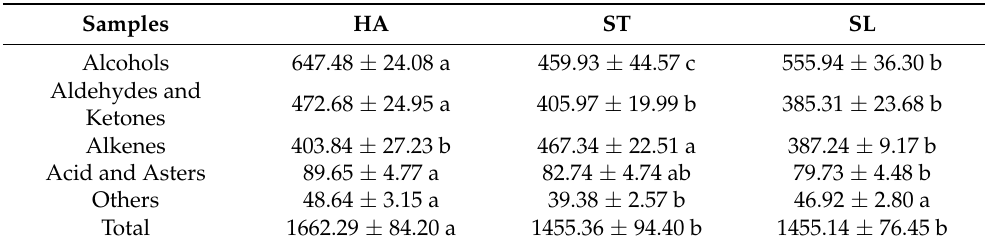
Table 3. Analysis of aroma species and contents in orange dark tea with different fixing methods ( µ